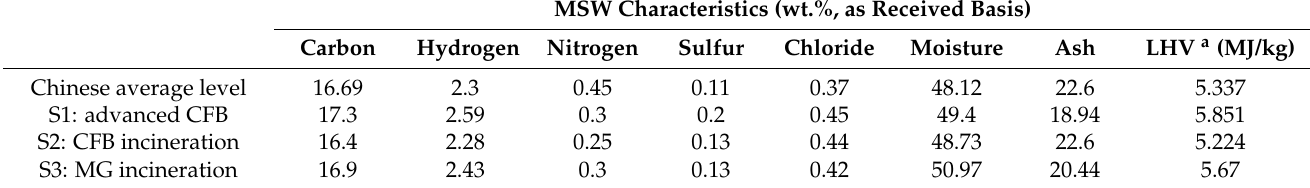
Table 1. Characteristics of MSW.